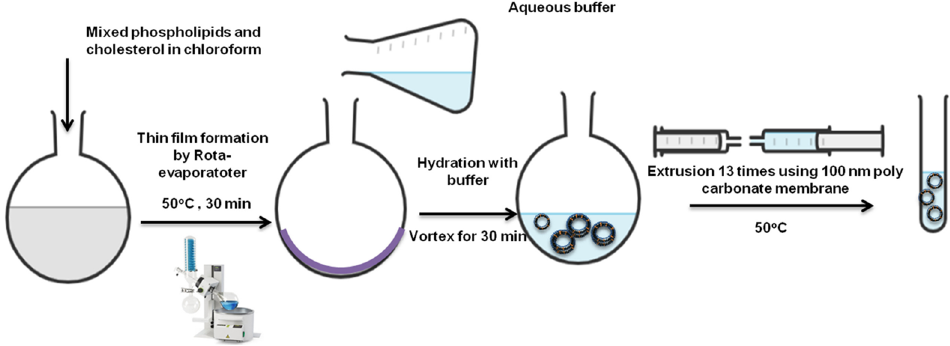
Figure 3. Liposomes preparation via thin-film hydration extrusion technique [57].